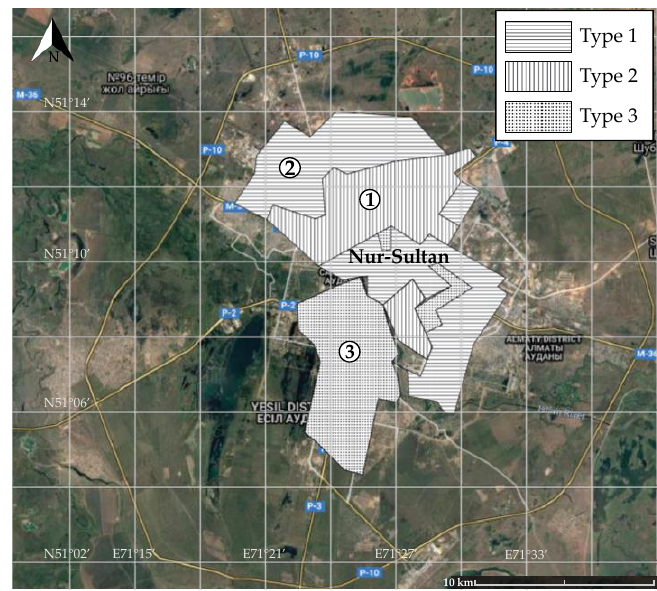
Figure 4. Zoning of the territory of Nur-Sultan city in accordance with the types of soil profiles. Table 3. Soil engineering properties in Nur-Sultan city.